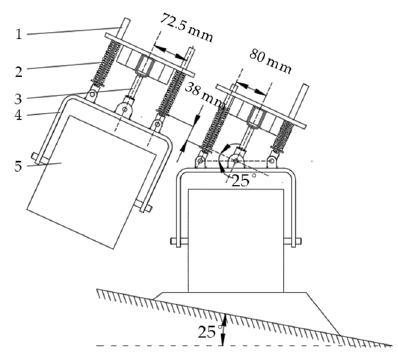
Figure 3. A motion sketch of the lateral balance state and lateral profiling state of the BPPD: (1) hanger rod, (2) balance spring, (3) upper bracket, (4) lower bracket and (5) press roller.